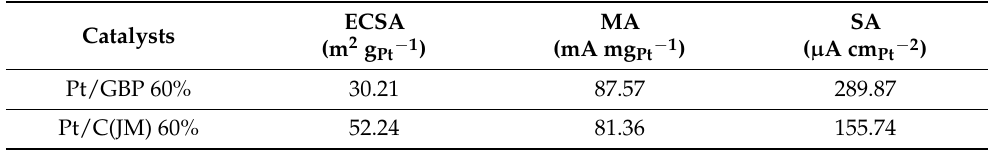
Table 4. Performance comparison of self-made Pt/GBP and commercial Pt/C.